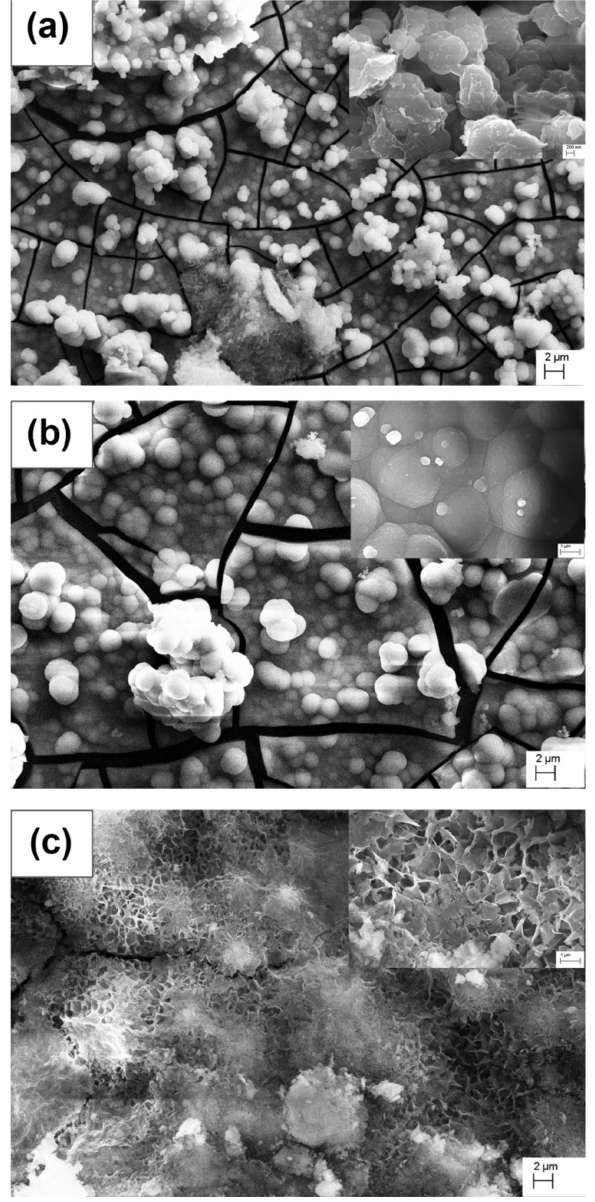
Figure 10. FESEM micrographs showing the bioactivity response of ( a ) Mg-1Sn; ( b ) Mg-5Sn; ( c ) Mg-10Sn alloys after 14 days of